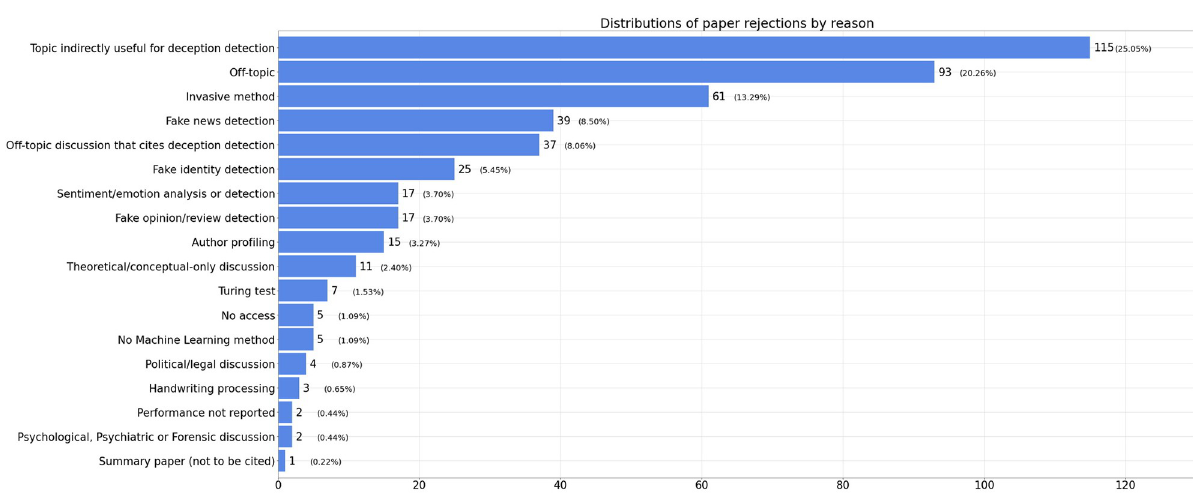
Fig 2. Rejection reasons. Papers that did not meet our selection criteria were rejected. The rejection reasons presented are those recorded for each article during the screening steps. This bar chart presents all those reasons and their frequency. Source: The authors (2022).